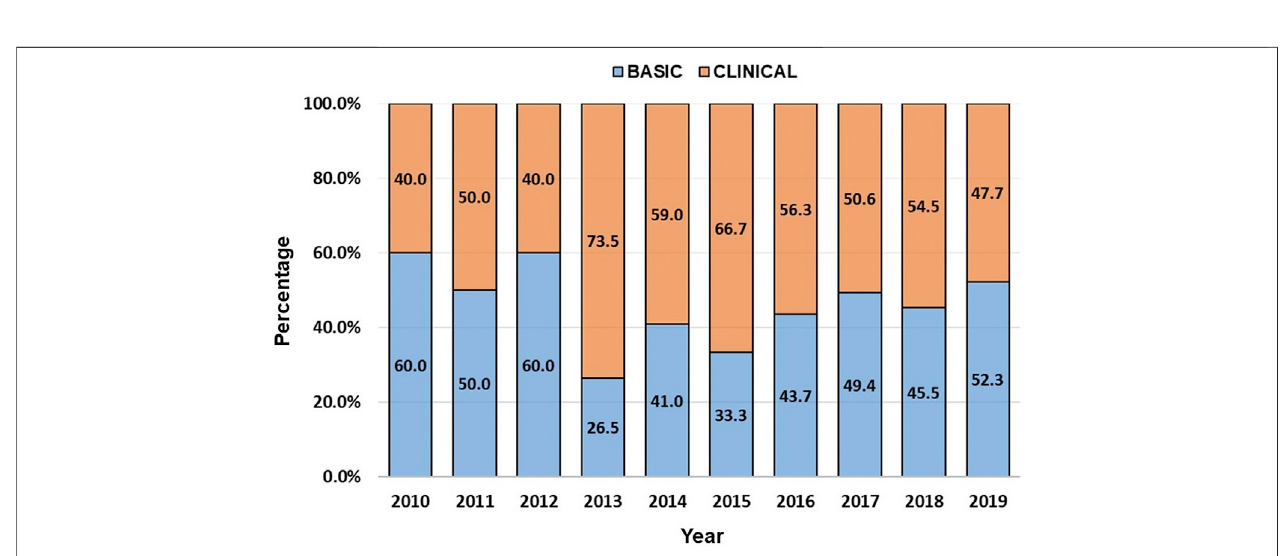
FIGURE 4 | Basic and clinical research trends on polymyxin resistance (2010 –